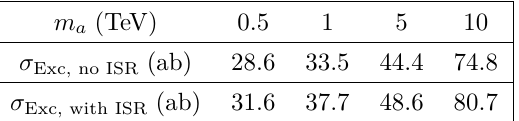
√ s is the direct conse- √ s = 14 TeV